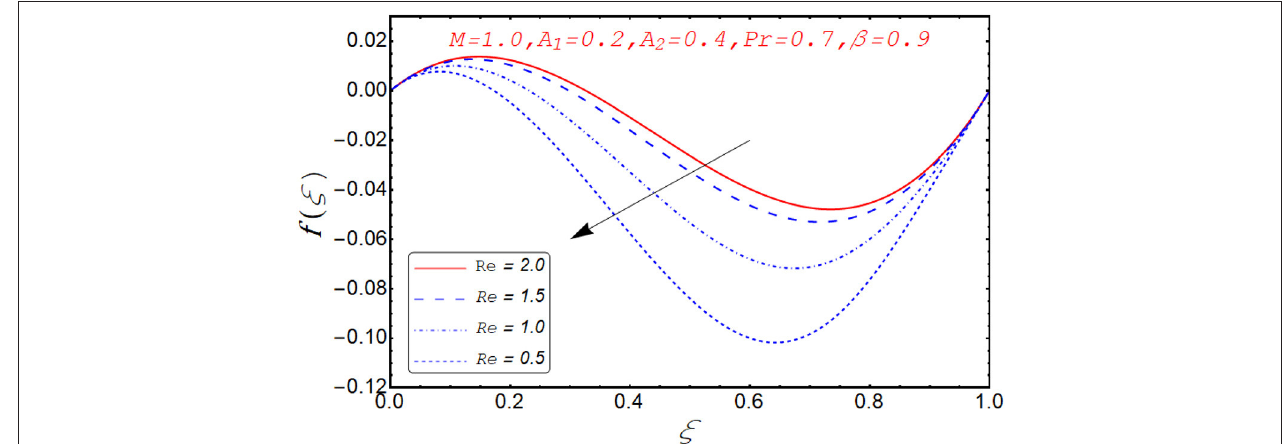
FIGURE 3 | Behavior of f ( ξ ) for different Re .